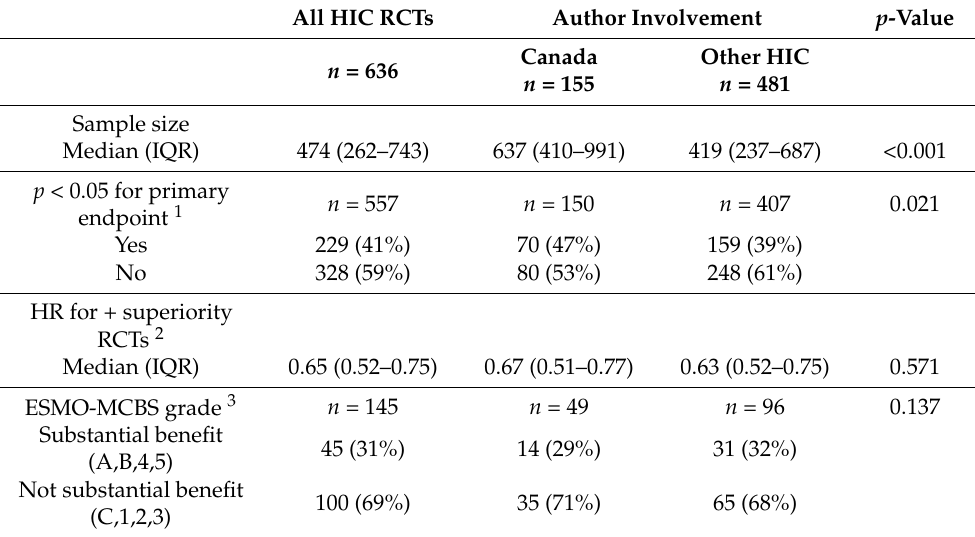
Table 2. Results of all oncology randomized controlled trials published by high-income countries during 2014–2017 ( n =